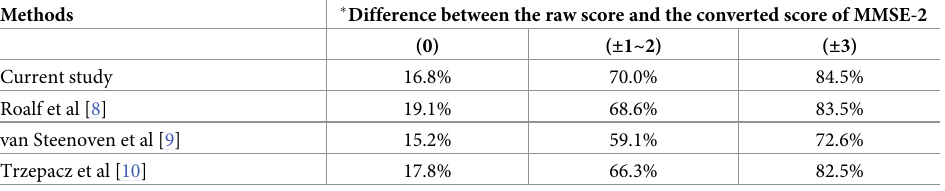
Table 4. Accuracy of the converted MMSE-2 scores against the clinically administered raw MMSE-2 scores.